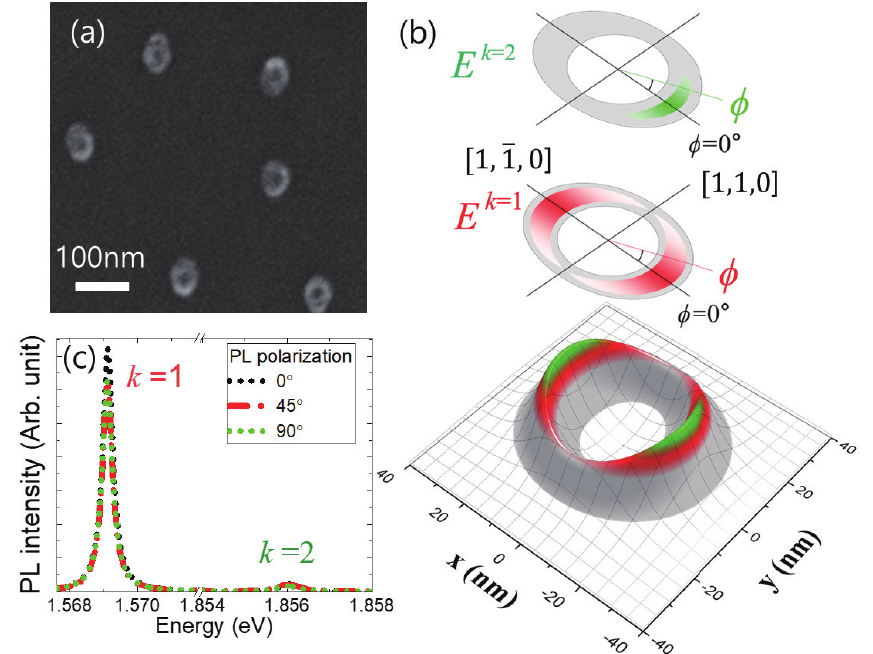
Figure 1. ( a ) FESEM image of uncapped GaAs QRs shows the density of QRs is enough low to perform micro-PL. ( b ) The structure of an anisotropic QR is shown theoretically regarding the AFM, where the lateral plane is defined in xy plane, and the vertical direction ( z -axis) corresponds to the height of the QR. Two different crescent-like wavefuntions of vertically localized states ( k = 1 and k = 2) are also shown schematically. ( c ) Two miicro-PL spectra were obtained through three linear analyzer angles (0°, 45°, and 90°), which correspond to the k = 1 states and k = 2